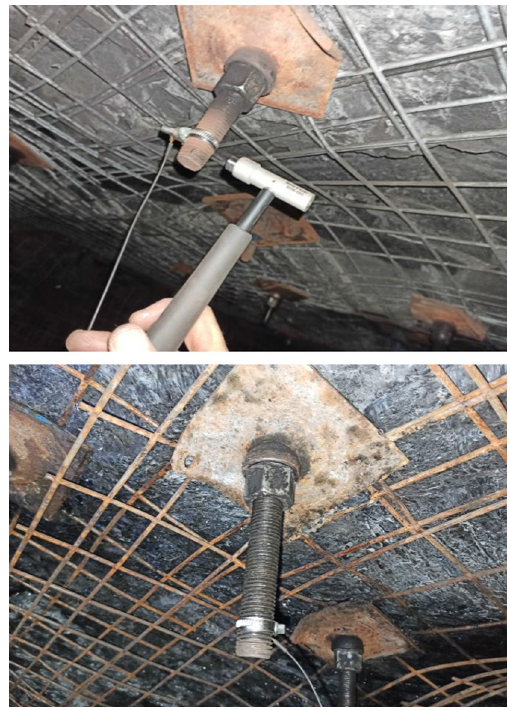
Fig. 1 Possible cases of discontinuity of resin layer (grout). 1-the grout; 2-the rock bolt, typical length 1.5–2.5 m; 3-the plate; 4-the nut; 5-the void space Fig. 2 An example of the test using impact